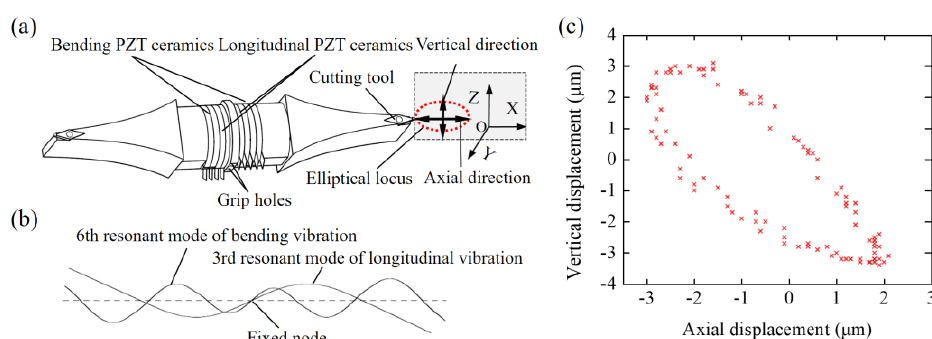
Figure 2. Experimental setup.